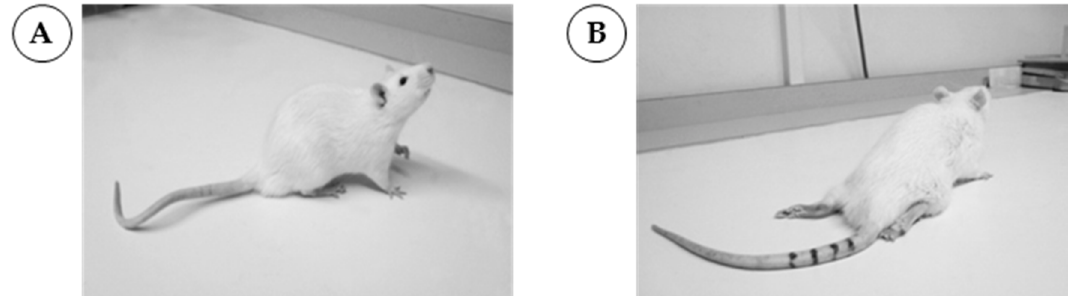
Figure 2. Visualization of clinical scores from male Lewis rat aged nine weeks. ( A ) Rat immunized with CFA and not developing clinical sign (clinical score of 0); ( B ) Rat immunized with S-palm-P0(180-199) peptide plus CFA and developing CIDP (clinical score of 3). Abbreviations: CFA, complete Freund’s adjuvant; CIDP, chronic inflammatory demyelinating polyneuropathy.